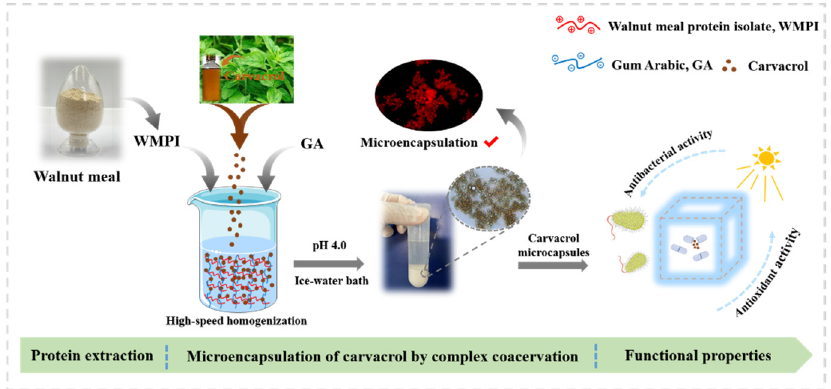
Figure 1. The proposed scheme for the preparation of the carvacrol encapsulated microcapsules.